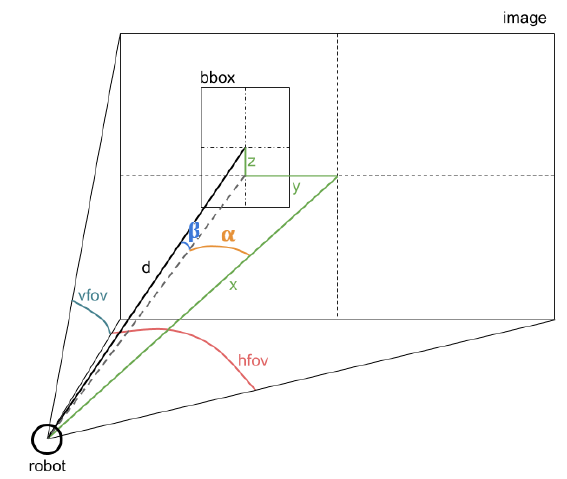
Figure 4. Graphical representation of variables in the formulas for the estimation of the 3D coordinates of detected people. ( x , y , z ) are the estimated person coordinates with the robot map frame. α and β are the angles of the detected person with respect to the position of the sensor. vfov camera and hfov camera are maximum angles for vertical and horizontal field of view, respectively. d is the distance to the detected person as perceived by the depth